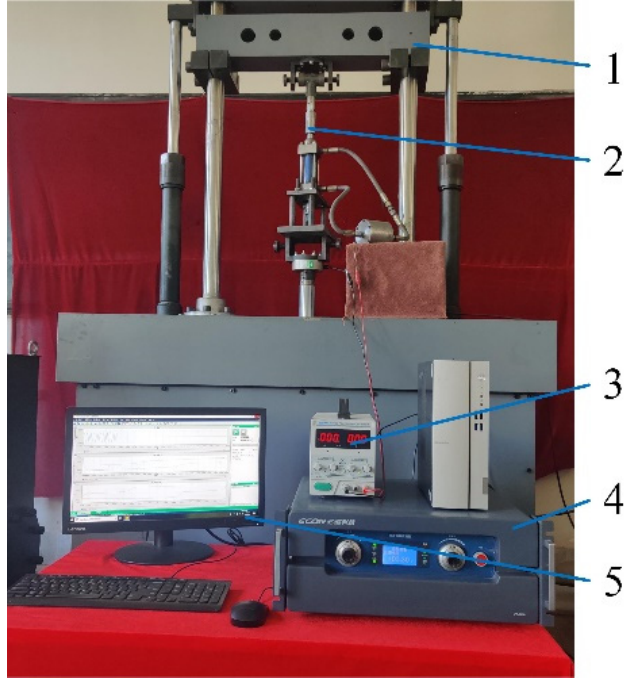
Figure 23. Experimental test rig of the proposed MR valve-controlled cylinder system: 1. Damper test system, 2. MR valve-controlled cylinder system, 3. DC power supply, 4. Electro-hydraulic servo controller, 5.